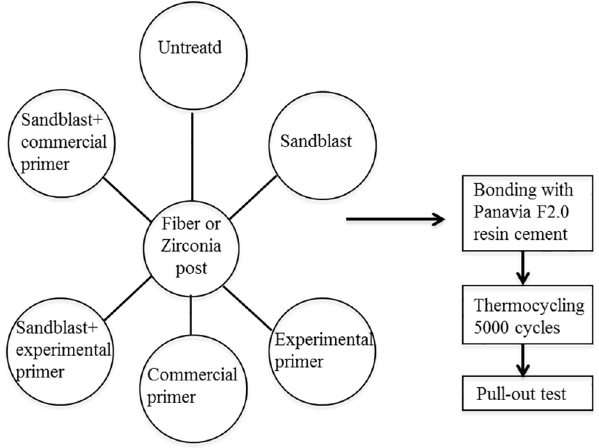
Fig 1. Schematic illustration of the measurement from the